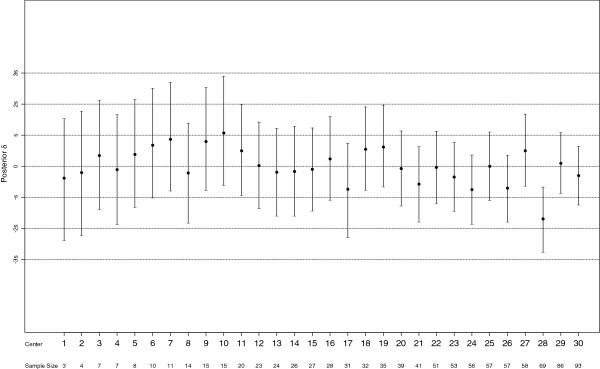
Posterior mean and 95% CIs of center log odds of good outcome (GOS = 1) for each center are presented under the final model. Posterior center log odds of good outcome greater than 0 indicates more good outcomes are observed in that center. Horizontal lines show ± s, ±2 s and ±3 s, where s is the posterior mean of the between-center standard deviation (s = 0.538, 95% CI: 0.397 to 0.726). Centers are ordered by enrollment size.